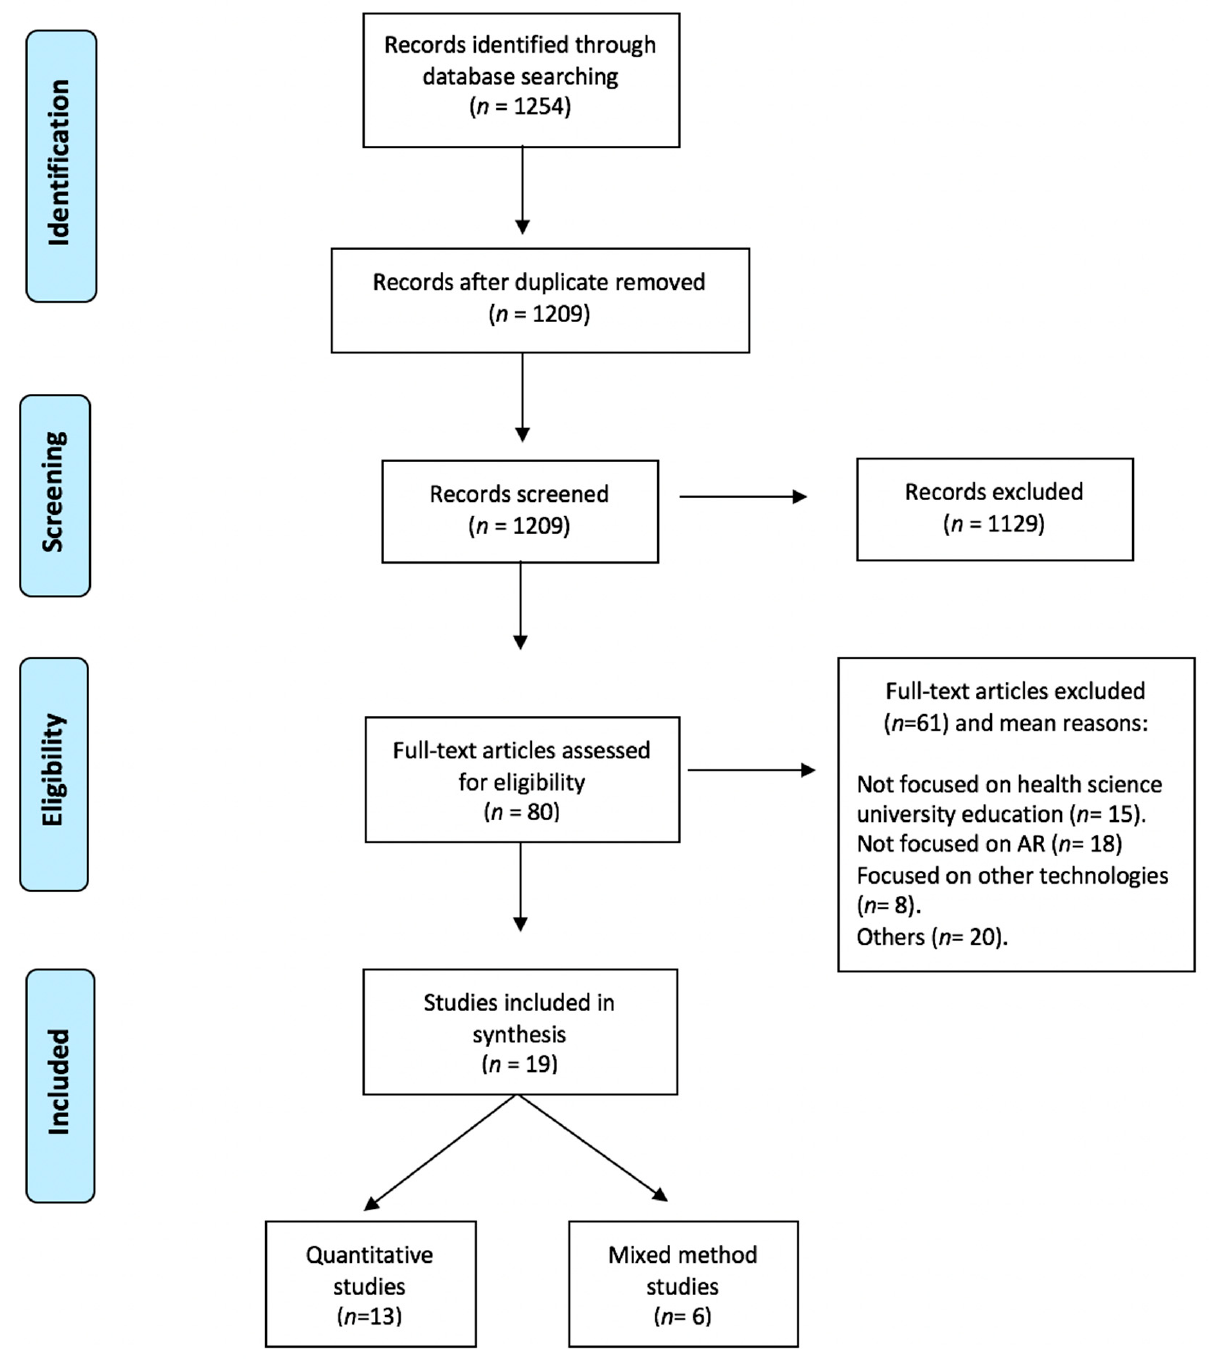
Figure 2. Flow chart of study screening process, according to PRISMA Framework.